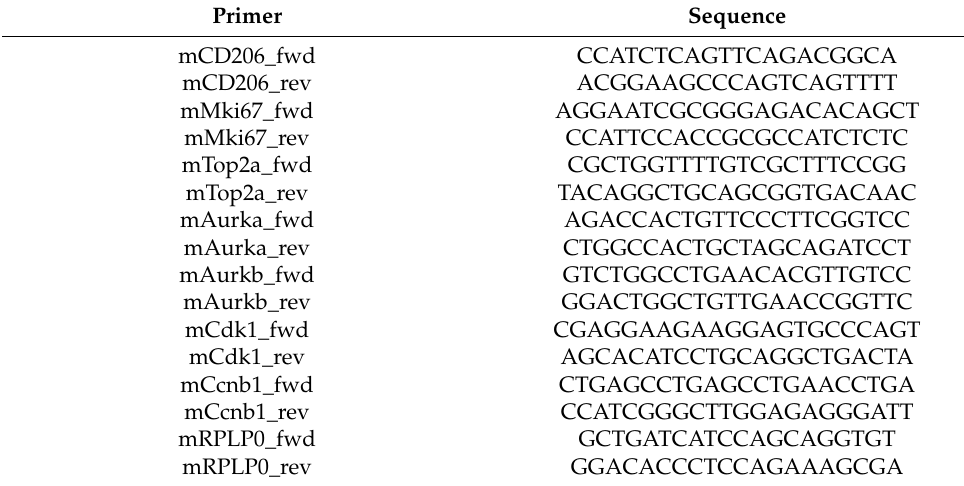
Table 2. Sequences of primers for